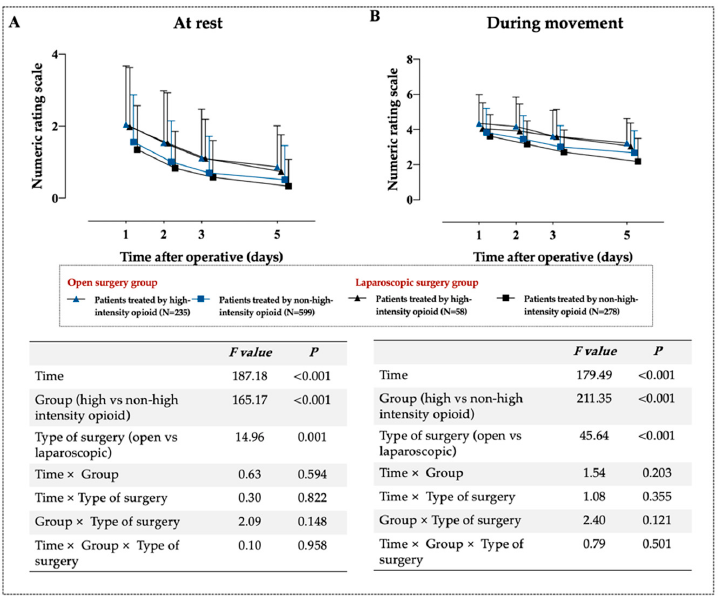
Figure A3. Average postoperative pain scores ( A ) during movement or ( B ) at rest by the different opioid use and the type of surgery. Cyan represents patients received open surgery; Light cyan represents patients received laparoscopic surgery. Table A1. Incidence of moderate to severe pain at rest and during movement.